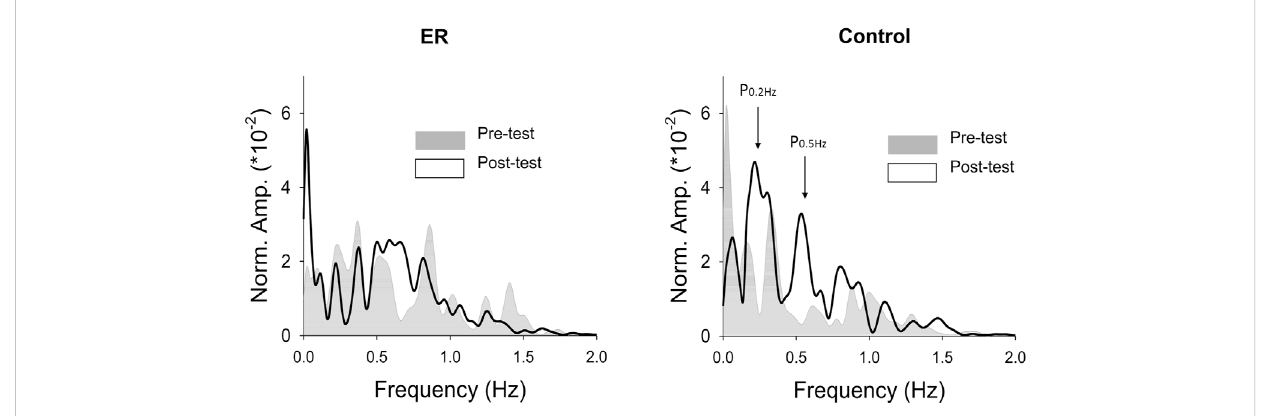
FIGURE 5 Thecontrastofpoolednormalizedpowerspectraofmeandischargetrace(MDT)betweenthepre-testandpost-testfromrepresentativesubjectsin the ER and control